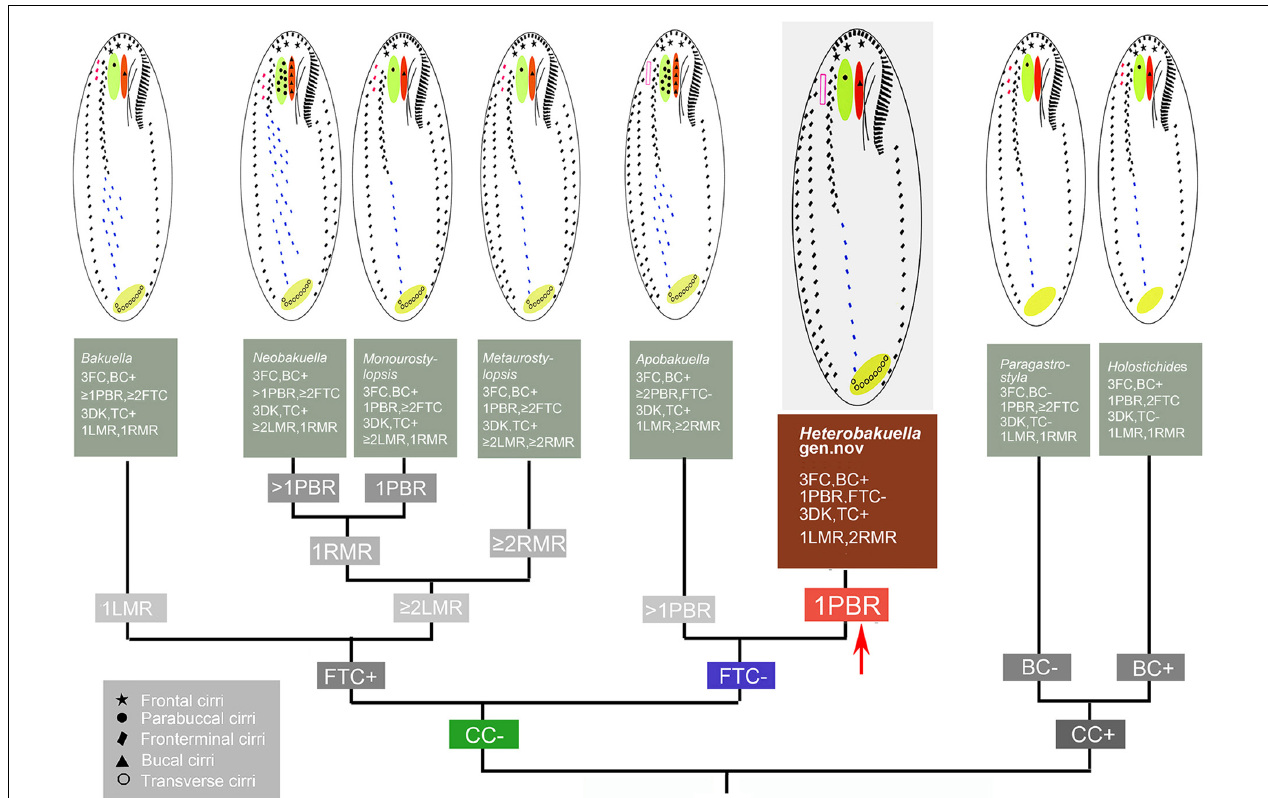
FIGURE 8 | Comparisons of morphologically related genera. BC, buccal cirri; CC, caudal cirri; DK, dorsal kineties; FC, frontal cirri; FTC, frontoterminal cirri; LMR, left marginal cirral row; PBR, parabuccal row; RMR, right marginal cirral row; TC, transverse cirri.